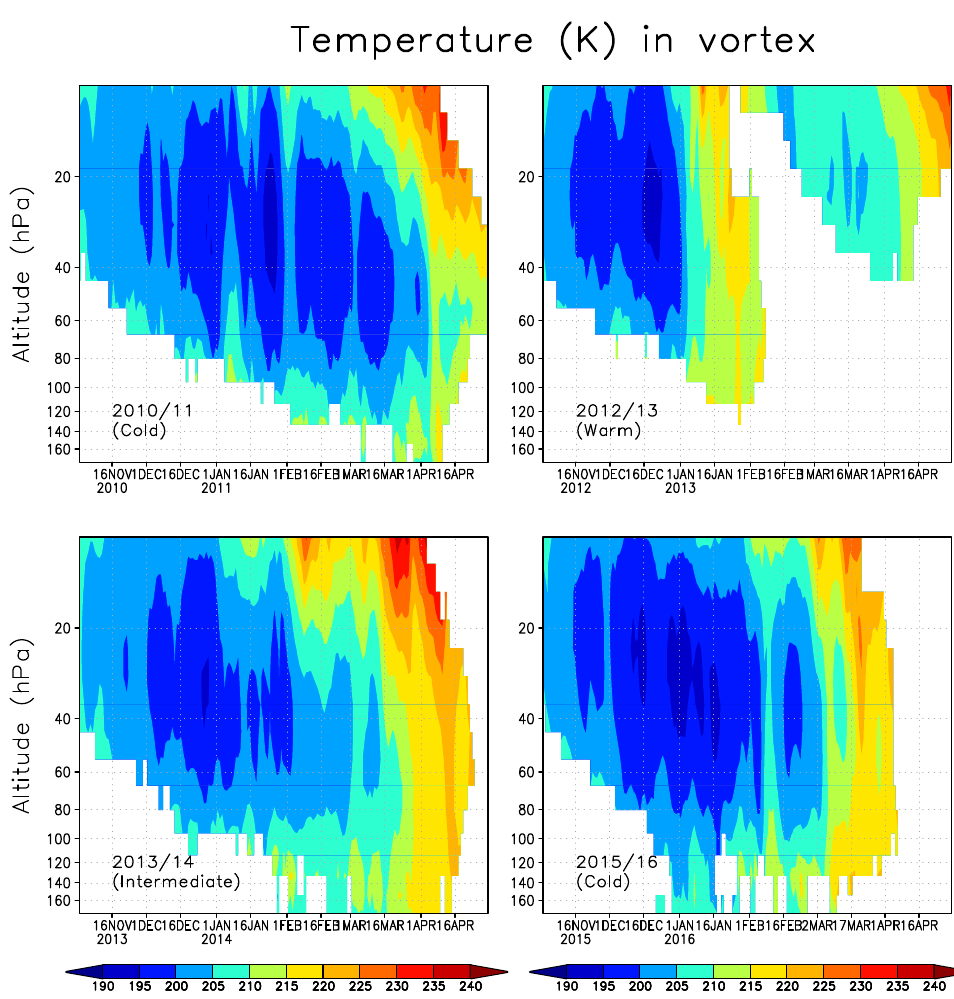
Figure 2. Vortex average temperature within the Arctic polar vortex between altitudes 170 and